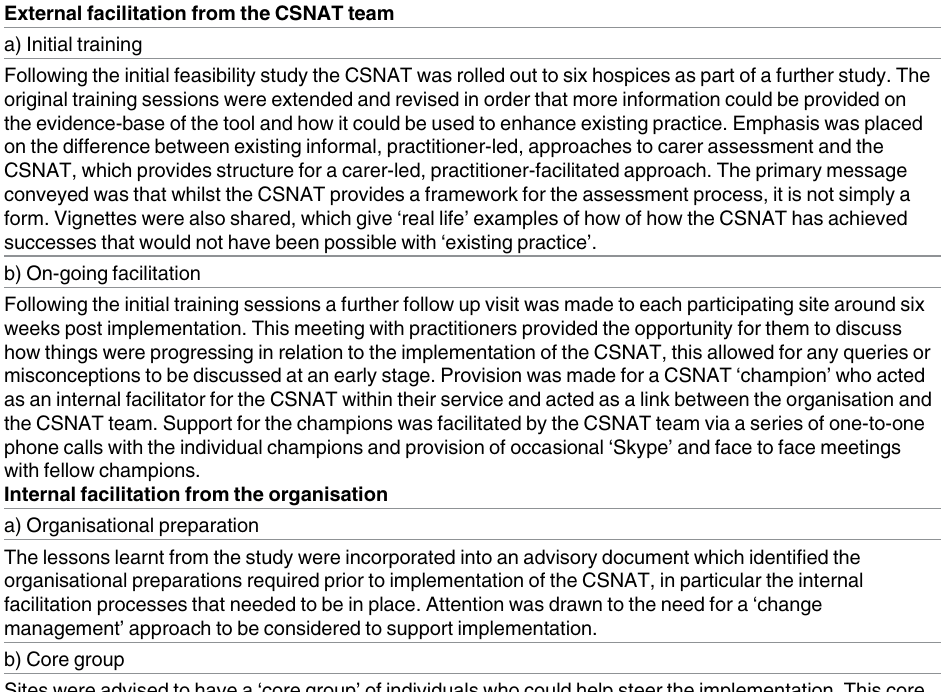
Table 4. Lessons learnt and implemented as a result of the feasibility